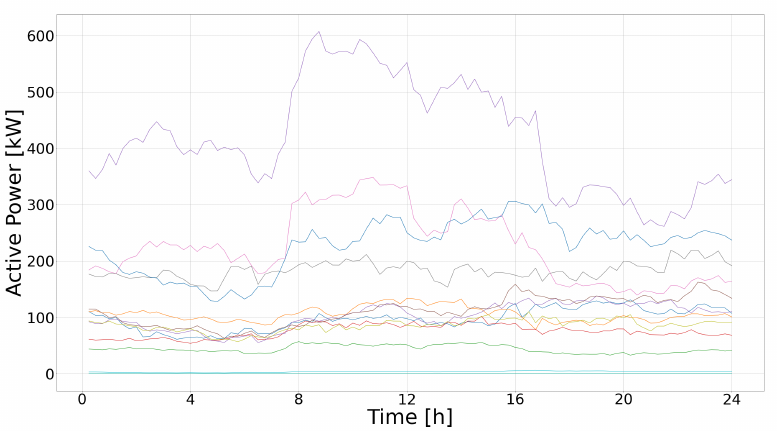
Figure 6. Examples of consumption time series used for the construction of the training scenarios for the RL agent.